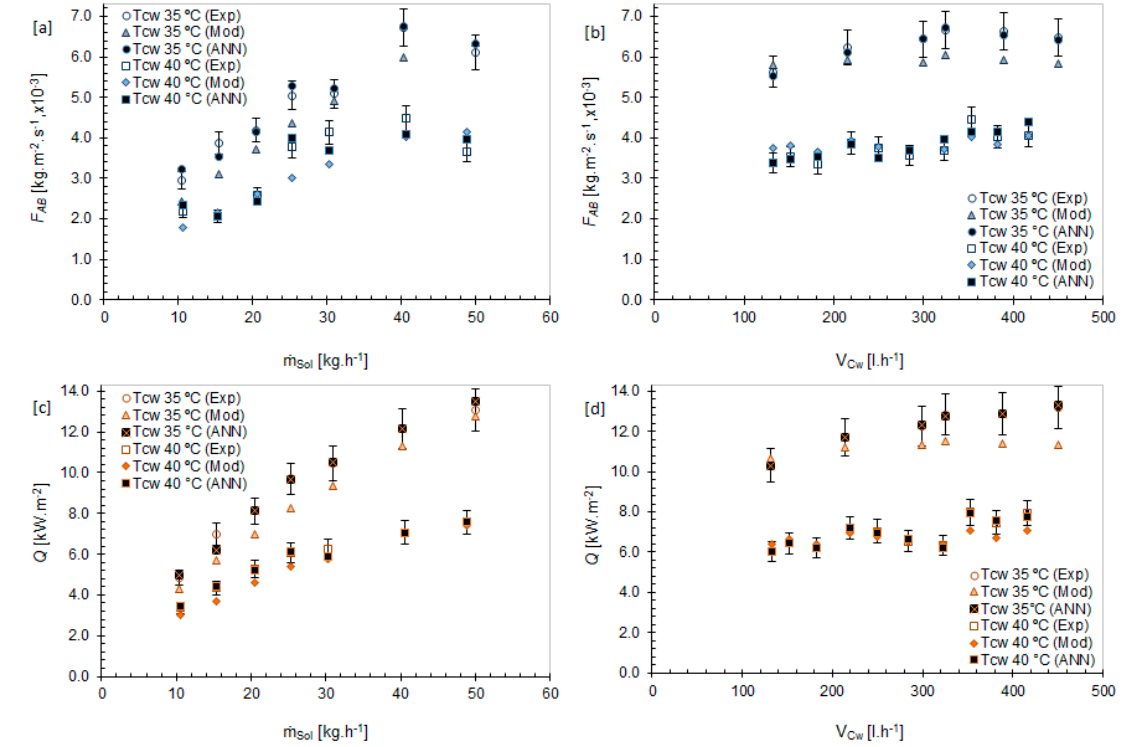
Figure 9. Experimental results vs. semi-empirical model and ANN model. Cooling-water temperature, solution mass flow, and cooling-water volumetric flow rate vs. ( a , b ) absorption mass flux, and ( c , d ) thermal load.